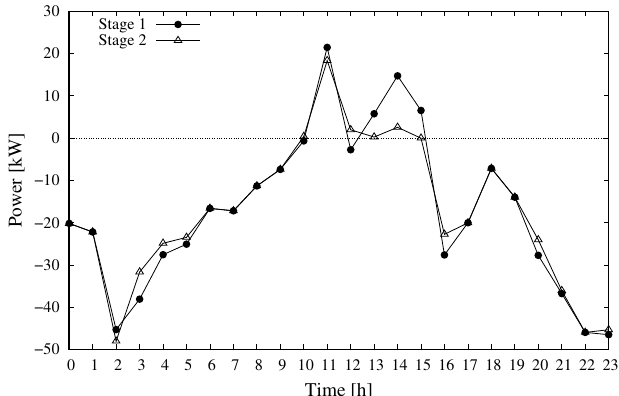
Figure 5. Aggregate profile of the energy community, computed at the end of the first and second stages when using the Parallel approach. Positive (negative) values correspond to energy injected to (absorbed from) the grid.